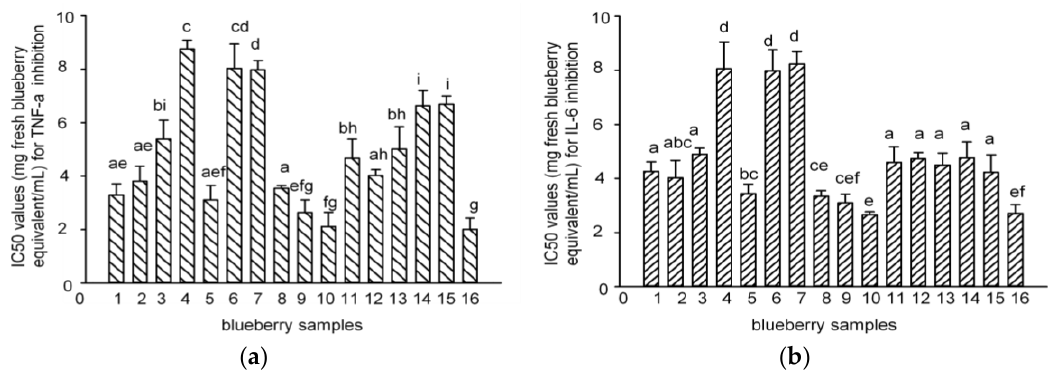
Figure 5. IC 50 values of the 16 blueberry polyphenol fractions for TNF-α ( a ) and IL-6 ( b ) inhibition. (The results have been expressed in terms of IC 50 (mg/100 g fresh blueberry equivalent, means ± SD, n = 3; columns with the different letters are significantly different, p < 0.05, n = 3).